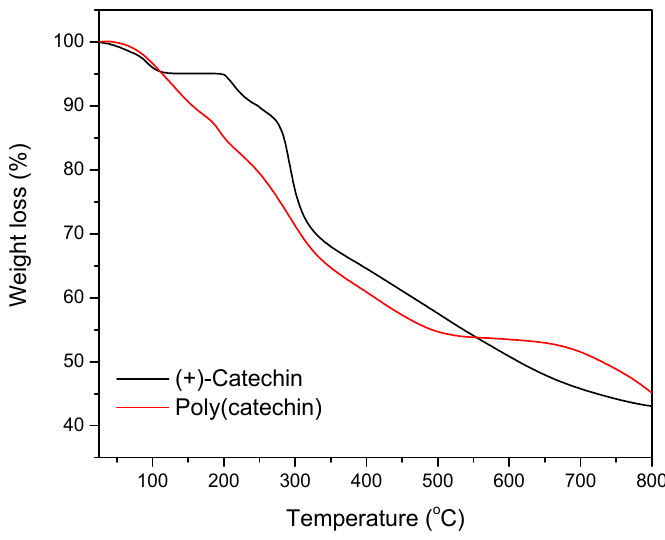
Figure 4. Thermal decomposition (TG) curves of (+)-catechin and poly(catechin).